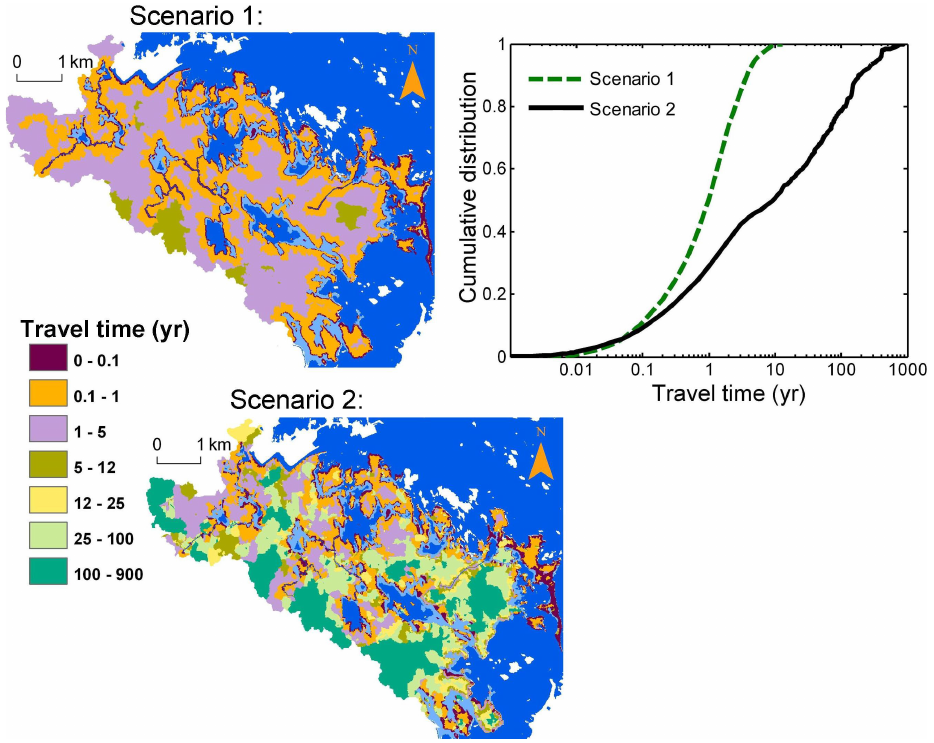
Fig. 2. The maps show advective travel times from different input locations in the Forsmark catchment to nearest surface water (inland or coastal) for the two considered K variability scenarios. The graph shows the resulting cumulative distributions of travel time to surface water from all upstream input locations (model